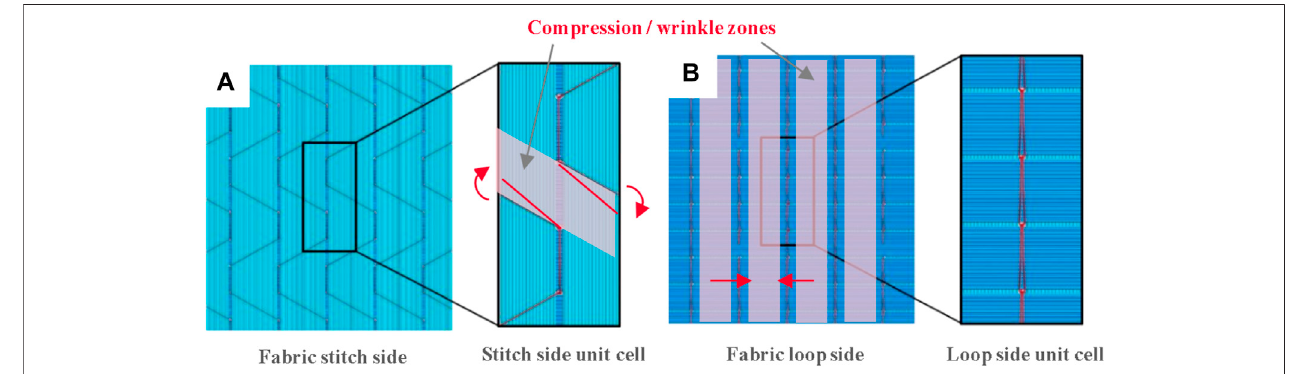
FIGURE 11 | Bar chart comparing bias extension and forming maximum wrinkle height values for six NCF formats.